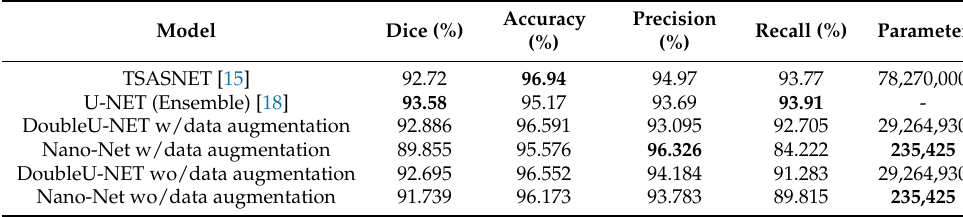
Table 5. Comparison with literature models.